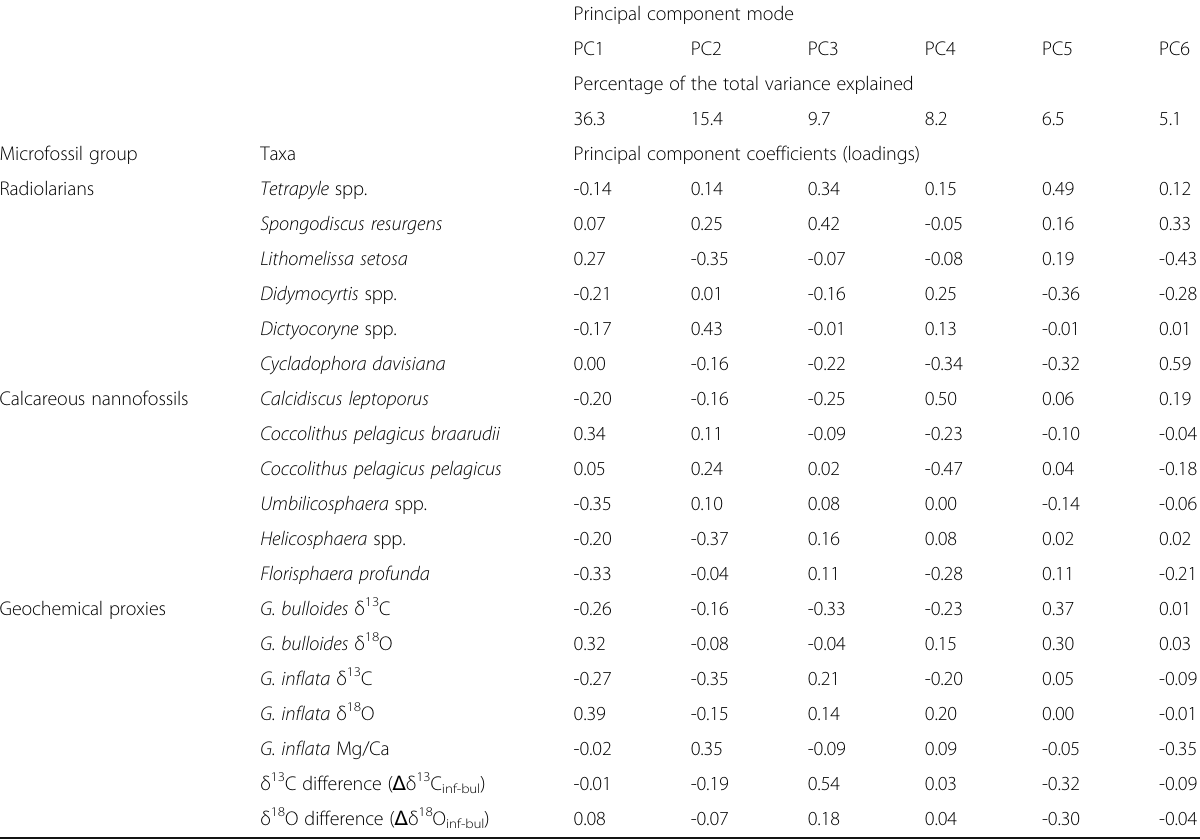
Table 1 The results of principal component analysis (PCA) on the Chiba composite section records. The percentage of the total variance explained and correlation coefficient (loading) for each mode are presented according to